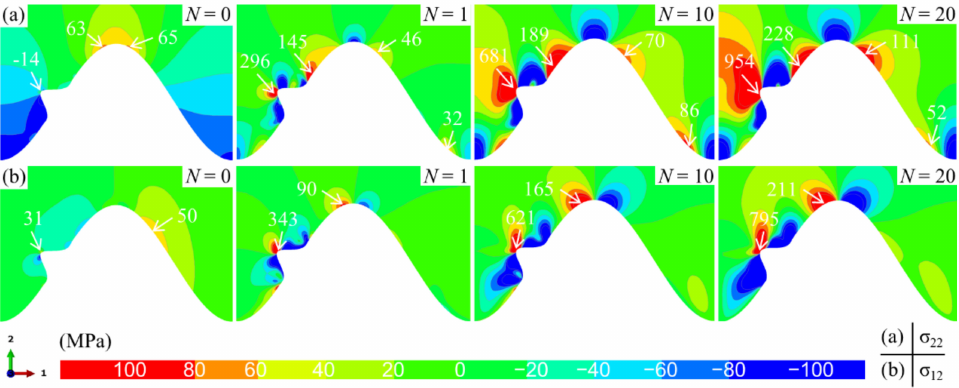
Figure 6. Distribution of the stress near the TC/BC interface with one bulge (at room temperature): ( a ) the normal stress σ 22 and ( b ) the shear stress σ 12